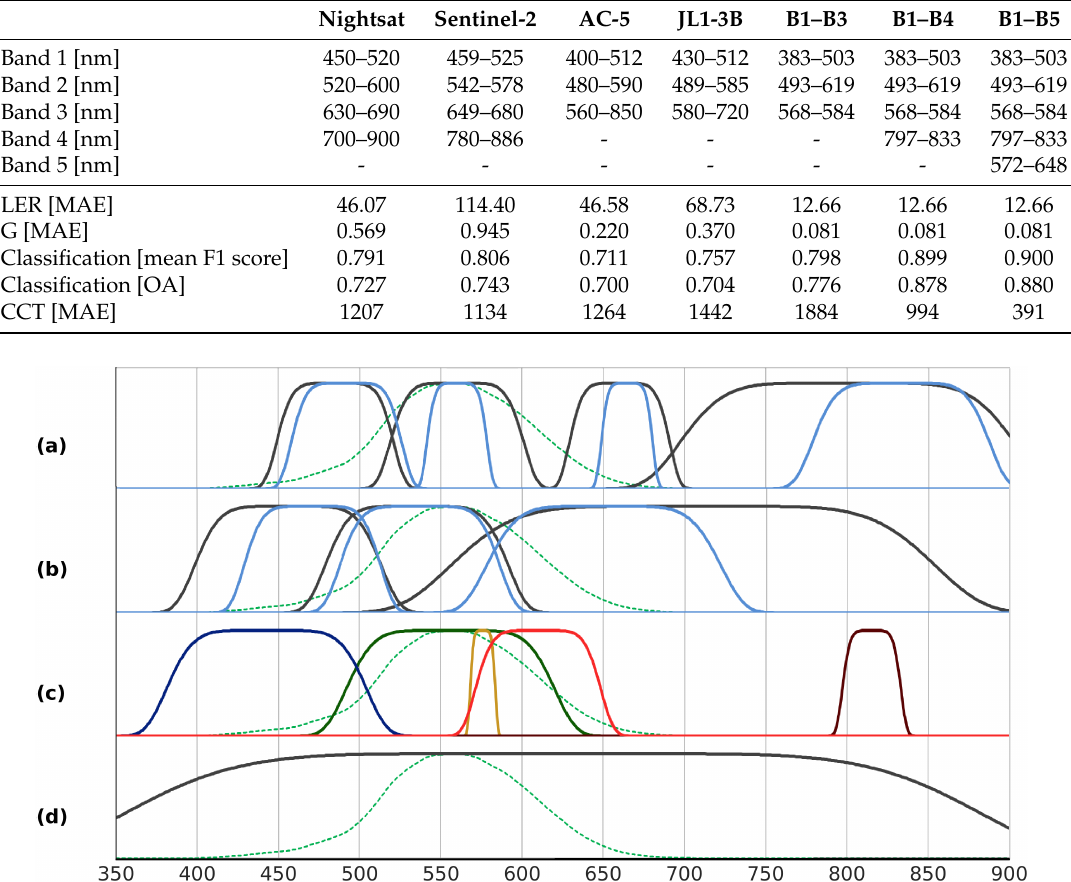
Table 3. Performance comparison with other band combinations. Note that results are based on a panchromatic band B0 with 374–864nm. Overall accuracy (OA) is the total number of correctly classified instances divided by the total number of instances.